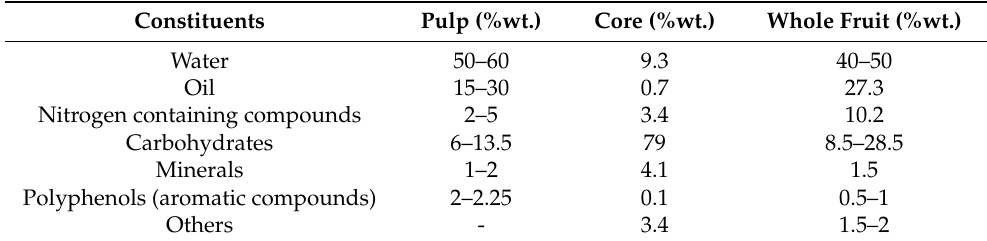
Figure 1. Chemical Composition of Olive Fruit. Table 1. Composition of Parts of the Olive